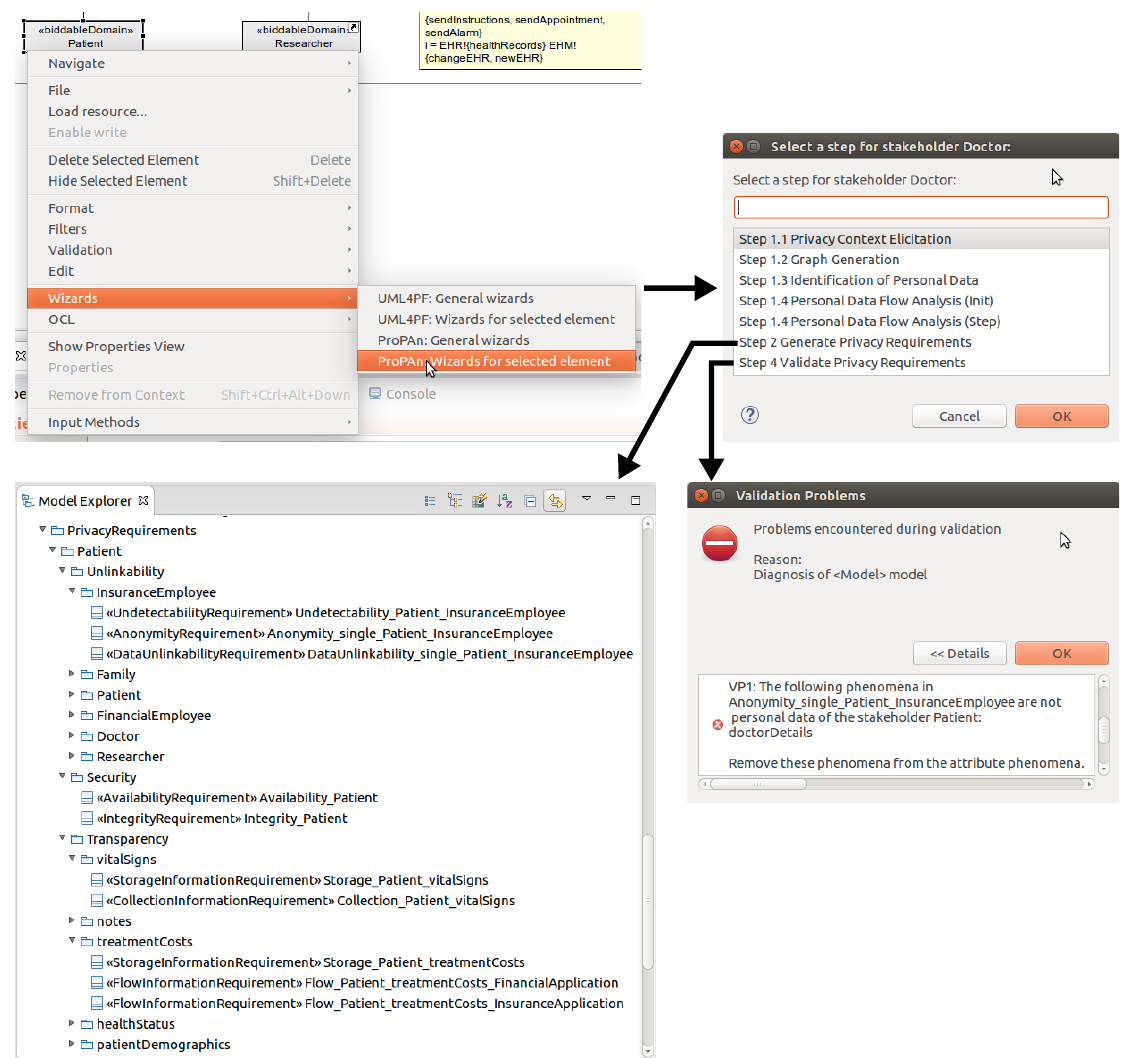
Figure 17. Generation and validation of privacy requirements with the ProPAn